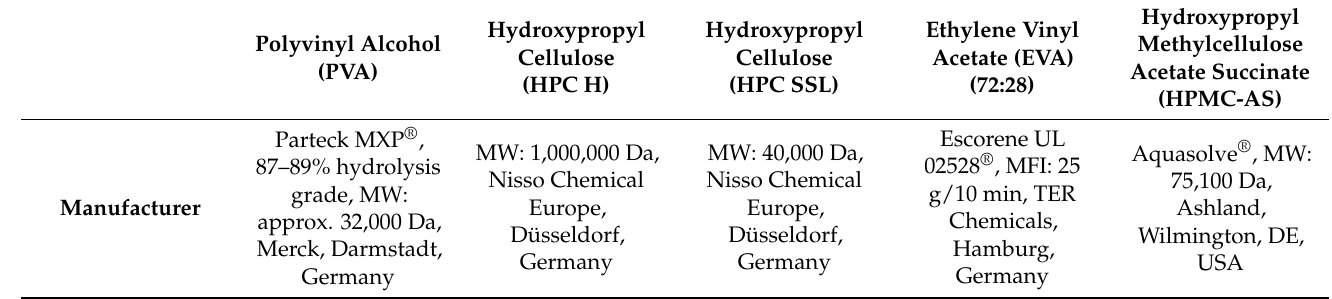
Table 1. SR-polymers used for VCM-formulation development (MW, molecular weight; MFI, melt flow